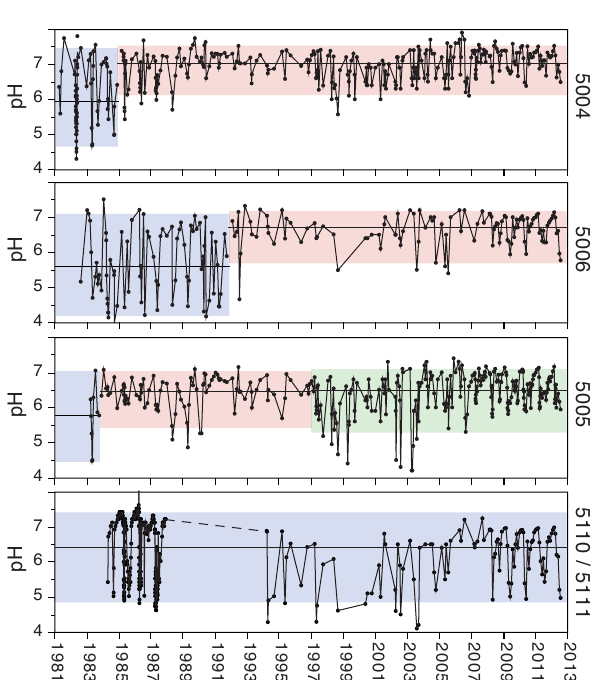
Fig. 3. Fluctuations of pH in the streams 5004, 5005, 5006, and 5110/5111. Blue areas mark the unlimed periods, red areas the limed periods, and green area the period after terminated